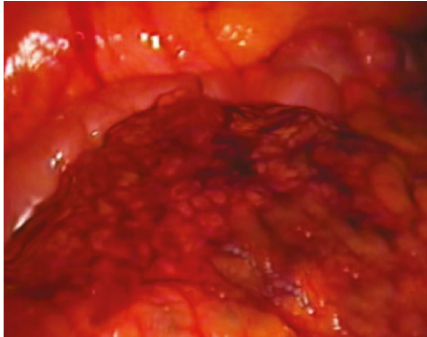
Figure 8: Omentum – vascular congestion and hemorrhage.